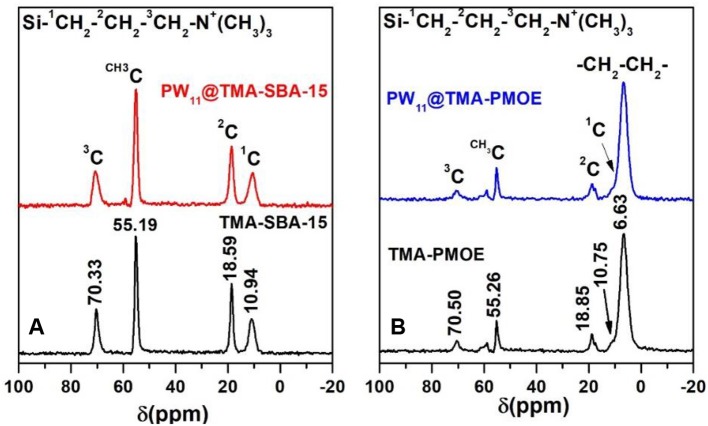
13C CP MAS NMR spectra of the TMA-functionalized supports and the resulting PW11 composites.